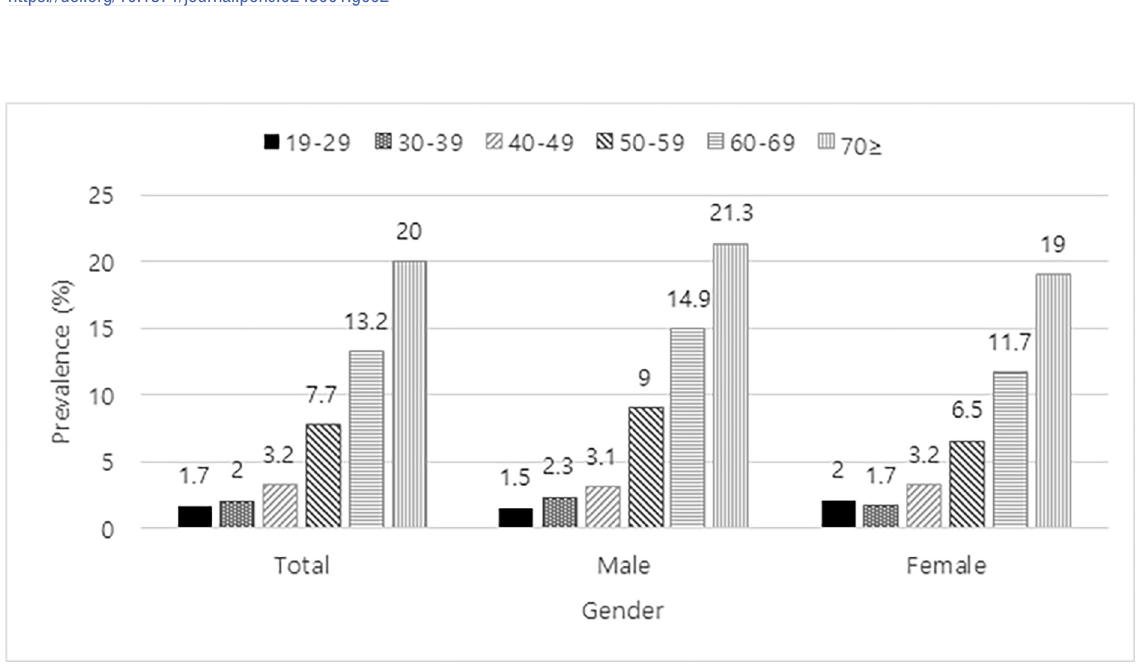
Fig 3. Prevalence of moderate hearing impairment (average of pure tone audiometry at 0.5, 1, 2 and 4k Hz more than 40 dB in the better ear). An increasing prevalence over advancing years was observed regardless of gender.